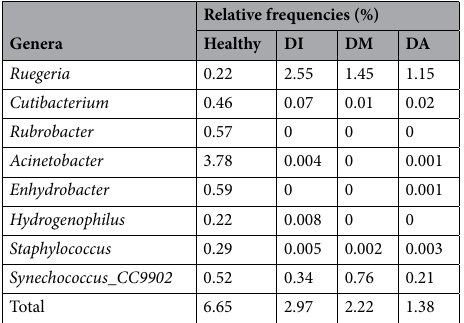
Table 3. Mean relative frequencies of genera that comprise the microbial core in healthy and at the initial (DI), intermediate (DM), and advanced (DA) stages of the disease in Tubastraea tagusensis .